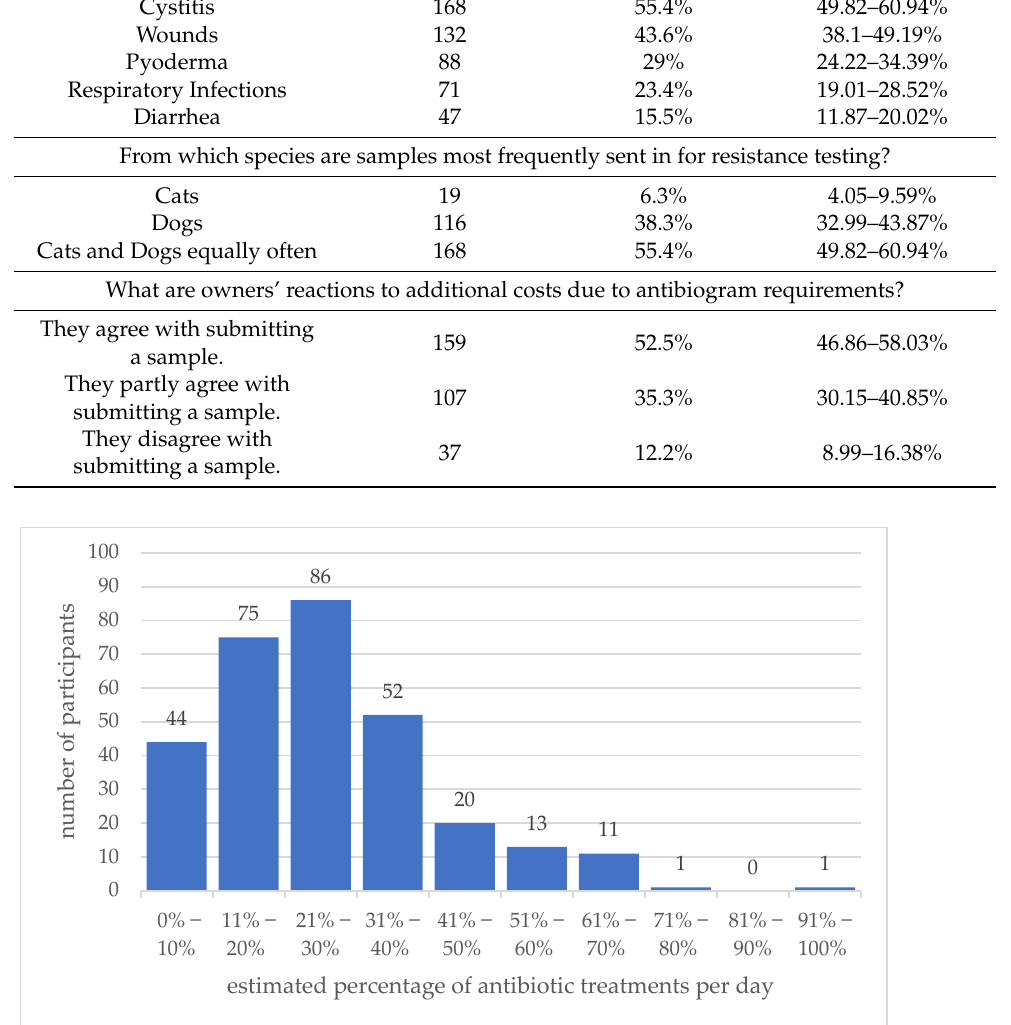
Figure 1. Antibiotic use. Number of participating veterinarians estimating how many dogs and cats treated daily (%) received antibiotic treatment. Bars indicate the percentages reported. On average, between 21% and 30% of cats and dogs treated daily received antimicrobial therapy. A total of 303 questionnaires were analyzed.